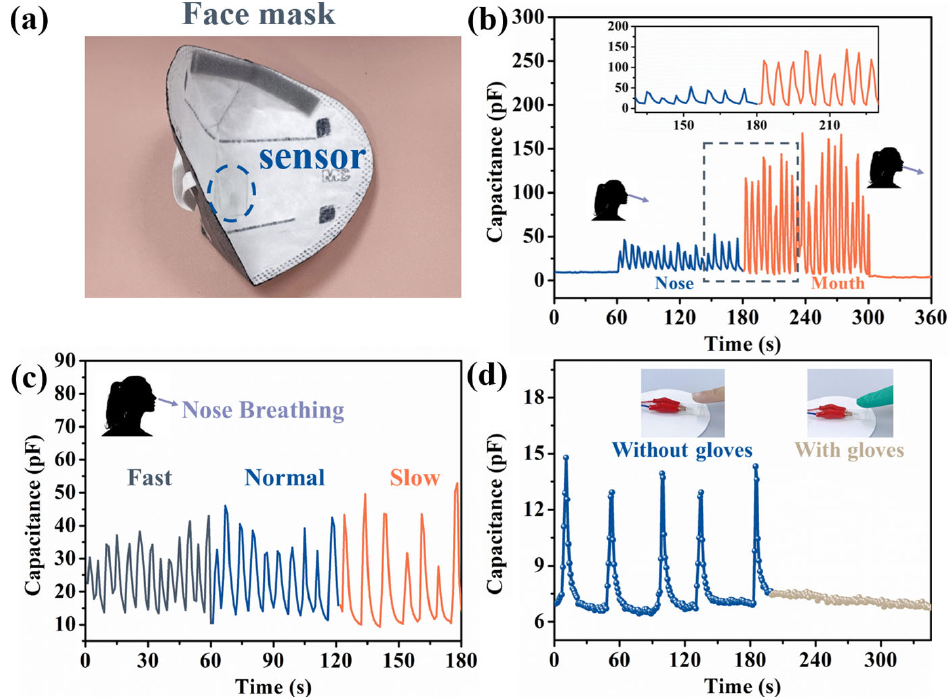
Figure 9. Breath monitoring applications of CIL@Cl-2 sensor. ( a ) Photo of the sensor on the face mask for human breath monitoring. ( b ) Response of the sensor under various breathing modes. ( c ) Response of the sensor under different breathing rates. ( d ) Response of the sensor approached by a finger with or without gloves.